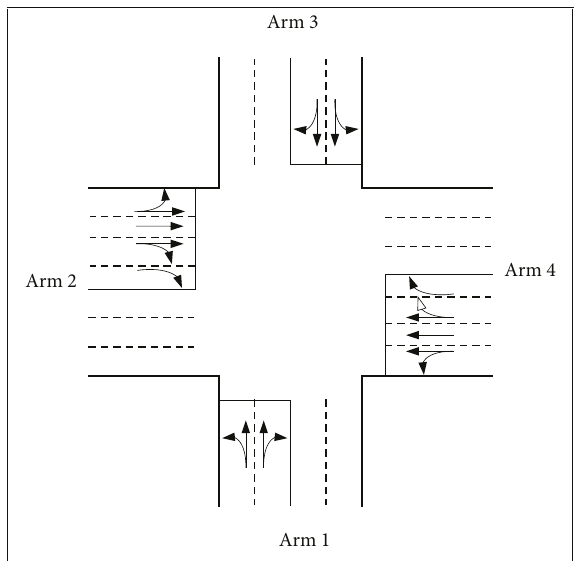
Figure 15: Optimized lane-marking inputs for the proposed refine- ment process at the surveyed